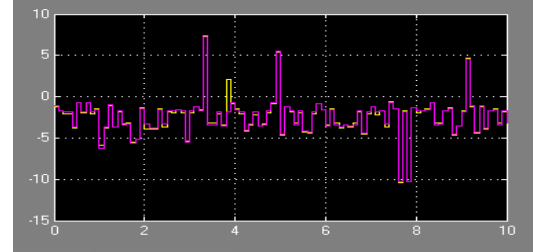
Figure 11. model with using ANN of Scope 2 ‘G 1 (u)’